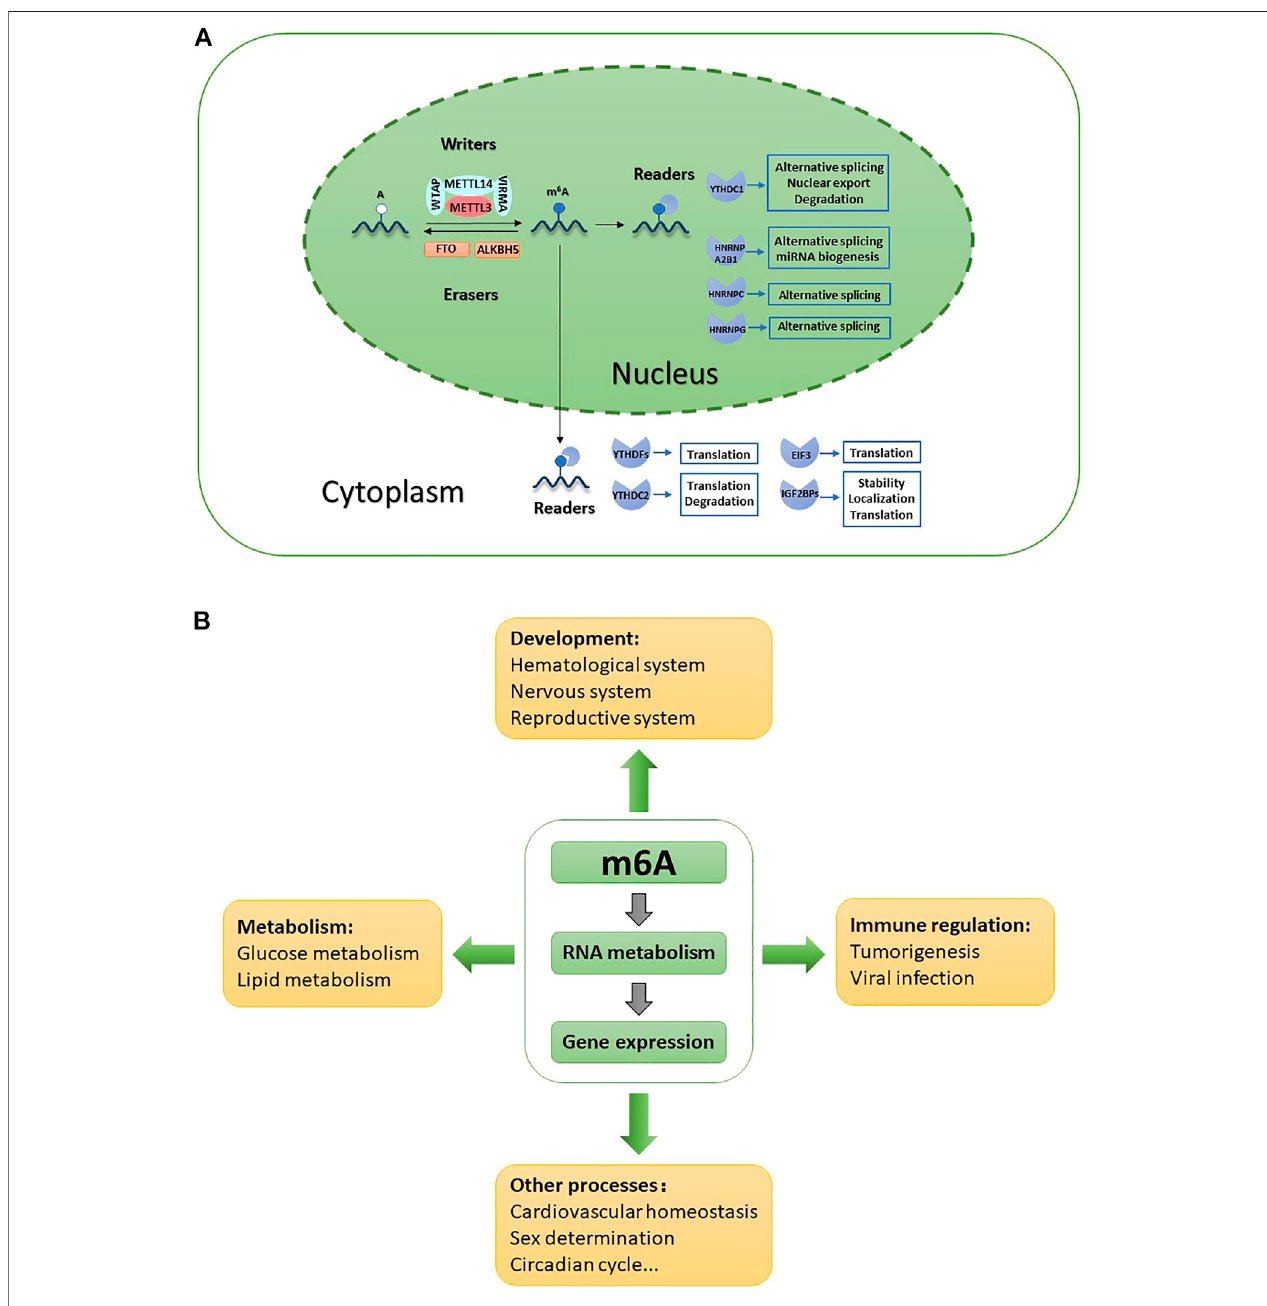
FIGURE 1 | Role of m6A in various biological functions. (A) m6A is installed by writers, removed by erasers and recognized by nuclear readers and cystoplasmic readers. m6A is involved in all aspects of RNAs metabolism and activity. (B) m6A is involved in both physiological and pathological processes through modulating gene